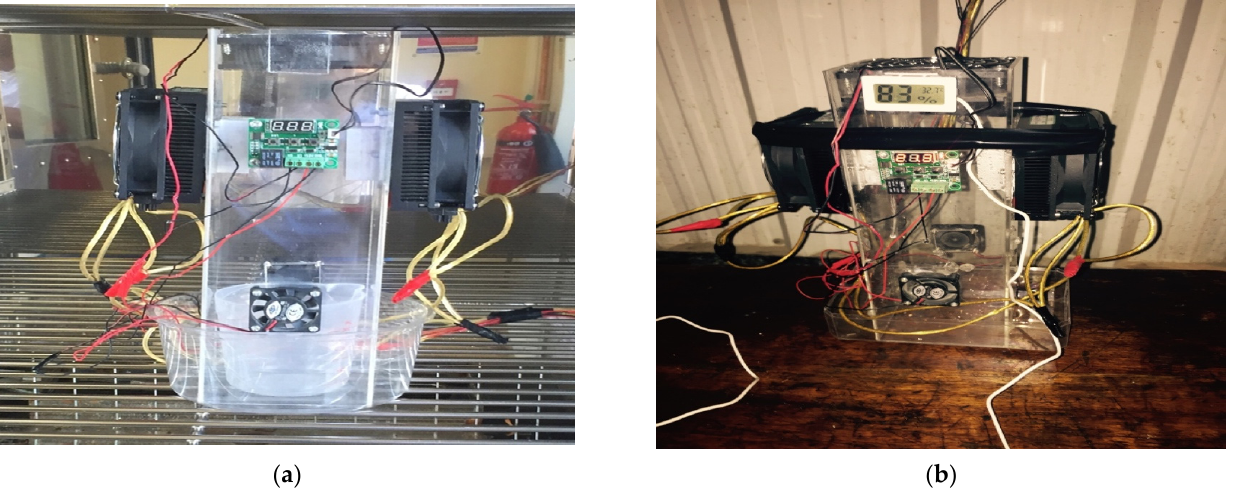
Figure 2. Photographs of ( a ) experiment apparatus in climate chamber and ( b ) experiment appa- ratus in actual condition.